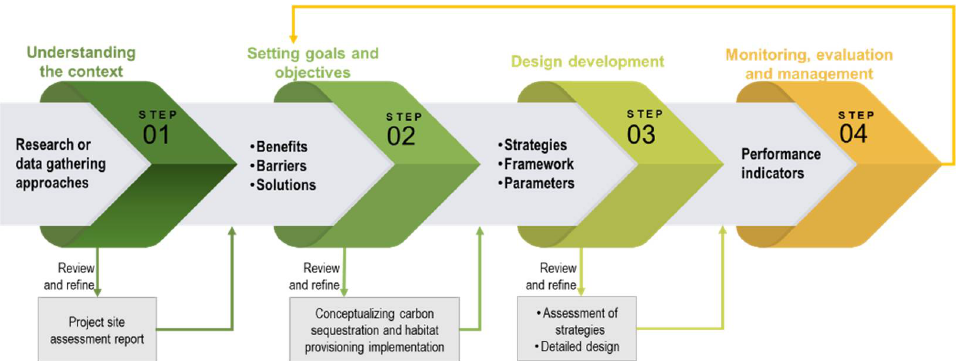
Figure 2. A conceptual framework for implementing carbon sequestration and habitat provisioning strategies through building design.